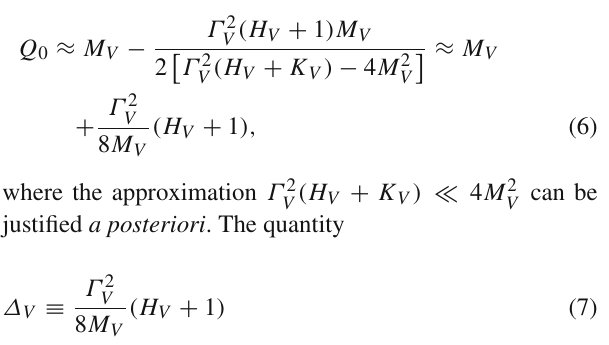
represents the displacement of the mode Q 0 from M V . Part of it is simply due to the Jacobian factor from the trans- formation of Eq. 2, and does not depend on the PDFs. The right-hand side of Eq. 6 depends on K V only at higher order in Γ V / M V because it enters as the coefficient of a quadratic correction to the Breit–Wigner functions, which is symmet- ric around M V . Both H V and K V are functions of y and M V , albeit the dependence on the latter is negligible in the range of experimental uncertainty on M Z ( ∼ 2 MeV) and M W ( ∼ 12 MeV) compared to the PDF uncertainties on Δ V . The shift Δ V determined from Eq. 7 is plotted in Fig. 2 as a function of the boson rapidity y for Z and W ± production. The error bars correspond to the RMS of the distribution obtained by sampling 100 replicas in the NNPDF30_nlo_nf_5_pdfas set from the LHAPDF library [13]. A comparison with NNPDF31_nlo_pdfas , which includes Drell–Yan measurements from the 8 TeV run of the LHC [14], has been performed as well, showing consistent results both in the central value and in the uncer- tainty. Numerical values are reported in Table 1 for three representative values of y . A negative shift with typical size | ∼ 13 MeV is observed in the central region | y | (cid:2) 3, | Δ V steeply increasing at larger rapidity values. This behaviour can be understood qualitatively in terms of the valence quark density xu V and xd V , which are typical benchmarks in PDF fits [12]. Indeed, for any derivable and positive-definite